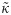
A graph showing variation of concentration of steady-state values of α, β and λ (in units of particle per cell) against thescaled substrate stiffness κ˜ (expressed in decimal logarithmic units).Initial conditions were random. The dashed lines show the approximate location of the transition region and the arrow marks the position of myofibroblast transition.